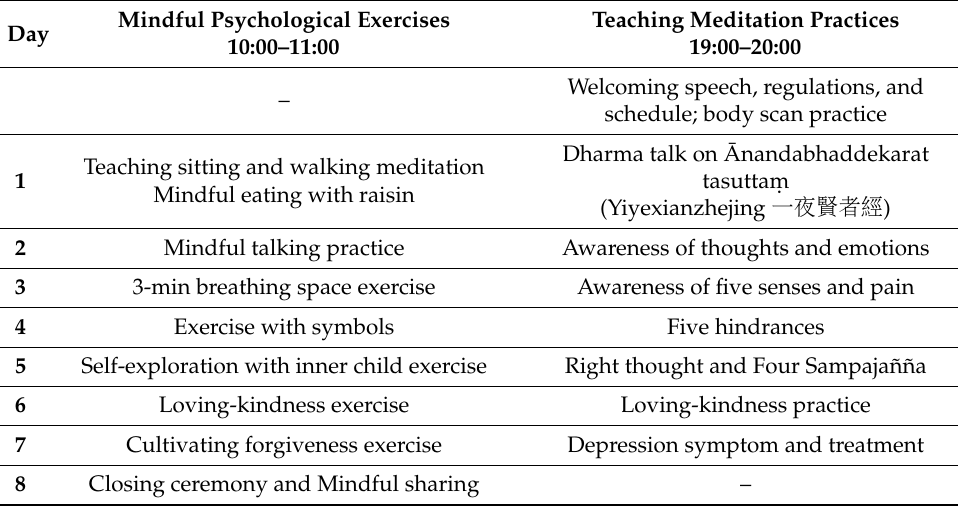
Table 2. Themes of mindful psychological exercises and meditation practices teaching.